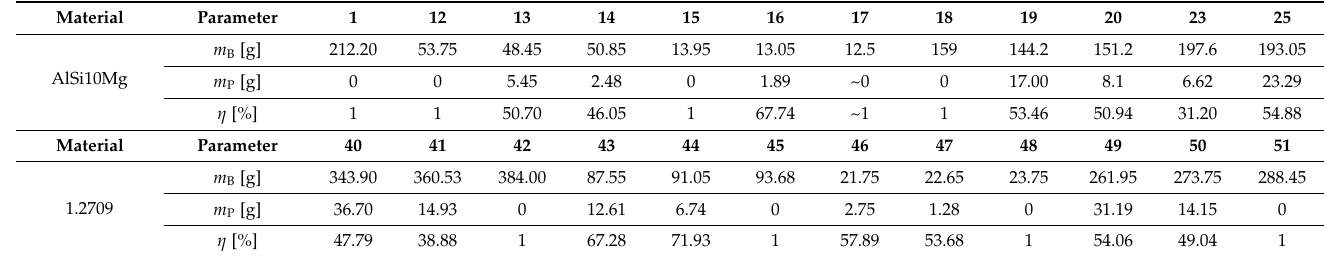
Table 2. Beam mass m B , particle mass m P and packing density η of the beams.